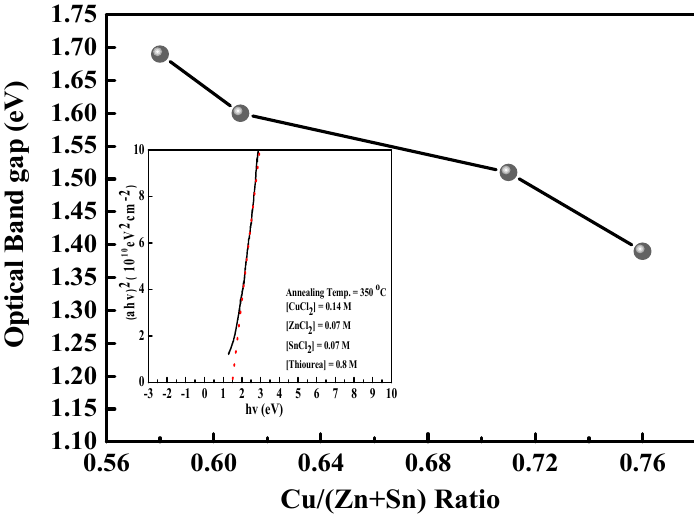
Figure 5. Optical band gap as a function of the Cu/(Zn + Sn) ratio, and the inset shows the plot of ( α h ν ) 2 against the photon energy of a Cu-poor and Zn-rich (Cu/Zn = 1.12) CZTS thin film.